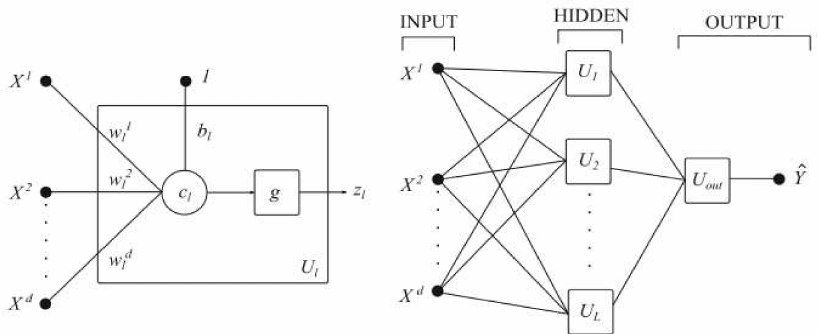
Figure 24. Left, schematic model of a perceptron U 1 and right, multilayer perceptron formed by L units, U 1 , . . . ,U L.